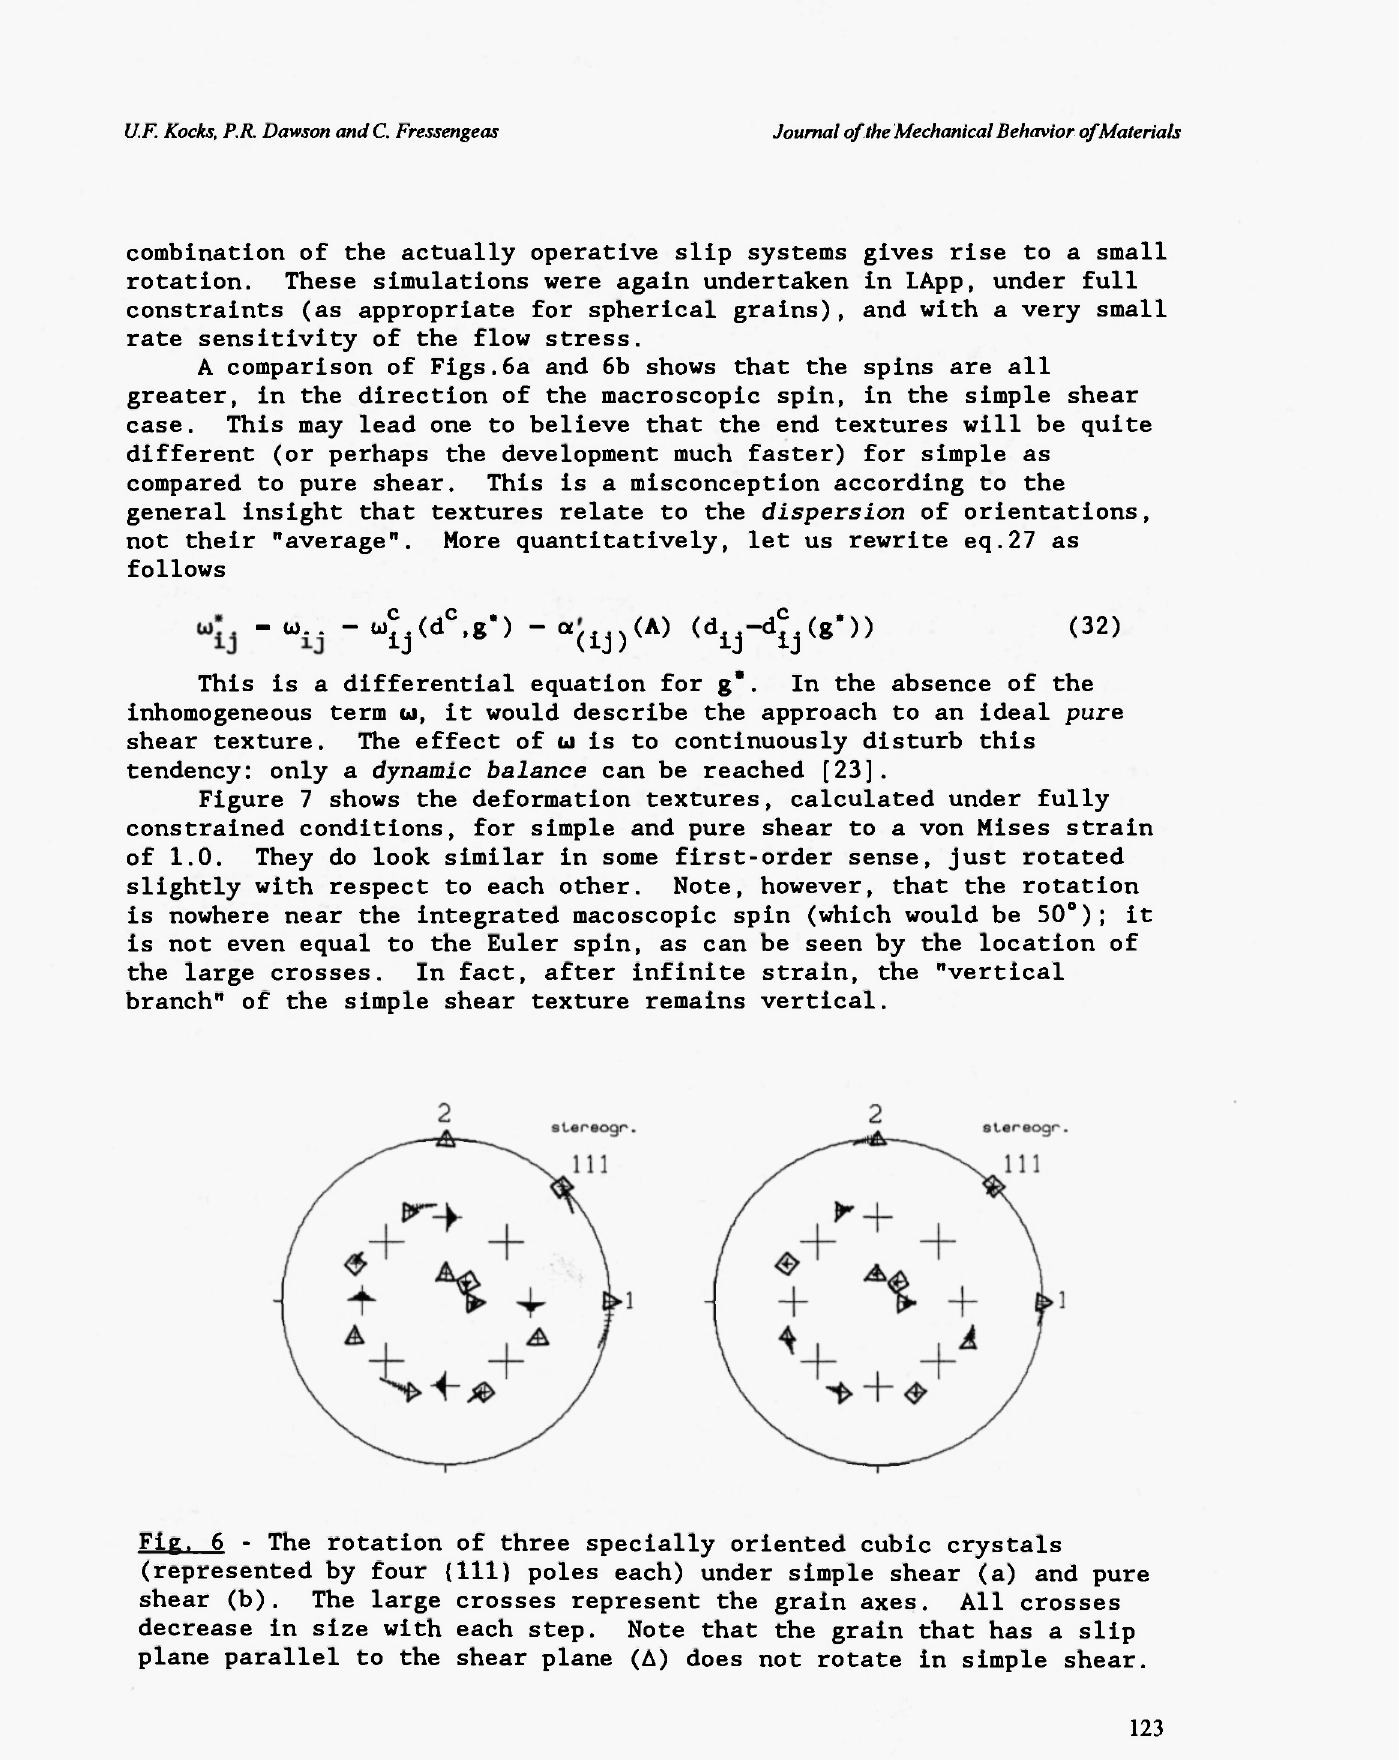
Fip. 6 - The rotation of three specially oriented cubic crystals (represented by four {111} poles each) under simple shear (a) and pure shear (b). The large crosses represent the grain axes. All crosses decrease in size with each step. Note that the grain that has a slip plane parallel to the shear plane (Δ) does not rotate in simple